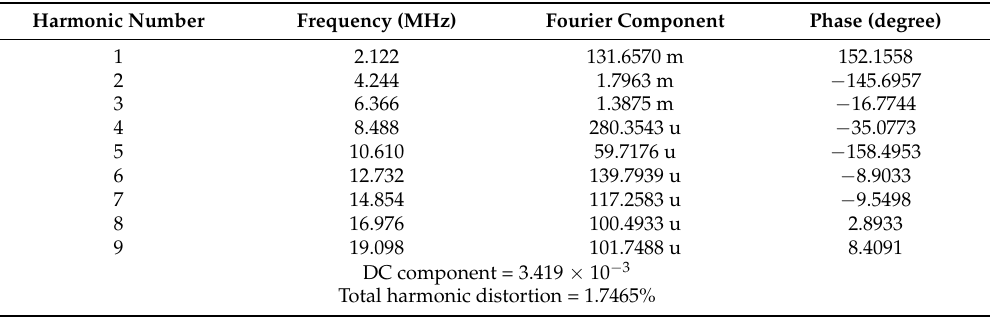
Table 4. Total harmonic distortion analysis of V o 1 in Figure 3.